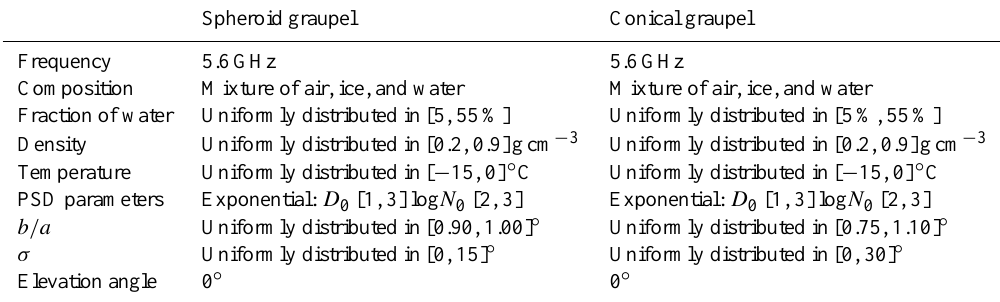
Table 1. Inputs to T -matrix simulations for graupel. Spheroid and conical graupels differ mainly for the axis ratio ( b/a ) and standard deviation of canting angle ( σ)